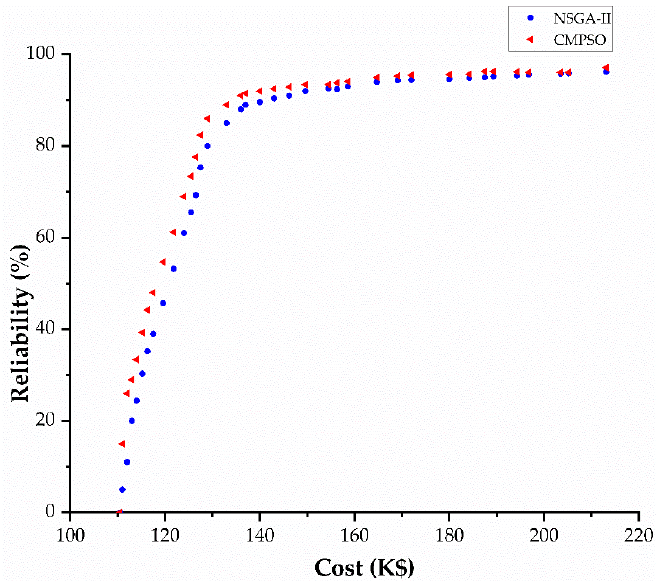
Figure 6. Comparative Pareto fronts of cost reliability—dimensional.